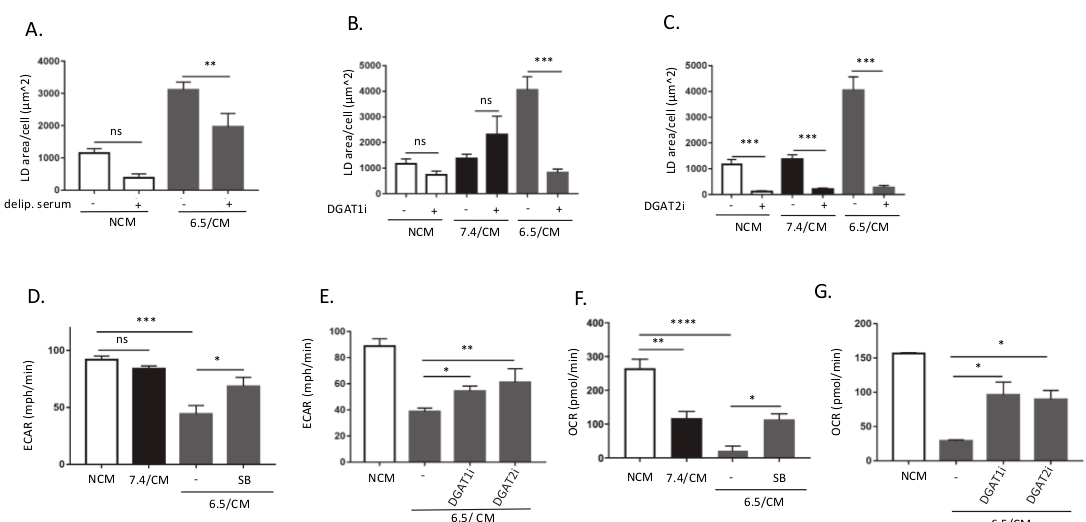
Figure 2. Diacylglycerol O-acyltransferase (DGAT)-dependent LD accumulation in dendritic cells (DCs) leads to metabolic reprogramming. DCs were incubated with non-conditioned medium (NCM) or treated for 2 or 3 days either with conditioned medium from AE17 or Ab1 mesothelioma cells maintained at pH 7.4 or pH 6.5 (7.4/CM and 6.5/CM, respectively). ( A – C ) Effects of 6.5/CM with or without delipidated serum ( A ), 15 µM A922500 (DGAT1i) ( B ), or 10 µM PF-06424439 (DGAT2i) ( C ) on cellular LD content, as determined using BODIPY 495/503 ( n = 3, ** p < 0.01, *** p < 0.001; ns = non-significant). ( D – G ) Effects of 6.5/CM with or without 5 µM SB-431542 and either DGAT1i or DGAT2i on the extracellular acidification rate (ECAR) ( D , E ) and oxygen consumption rate (OCR) ( F , G ), as detected using the Seahorse XF Analyzer ( n = 3, * p < 0.05, ** p < 0.01, *** p < 0.001, **** p < 0.0001; ns = non-significant).